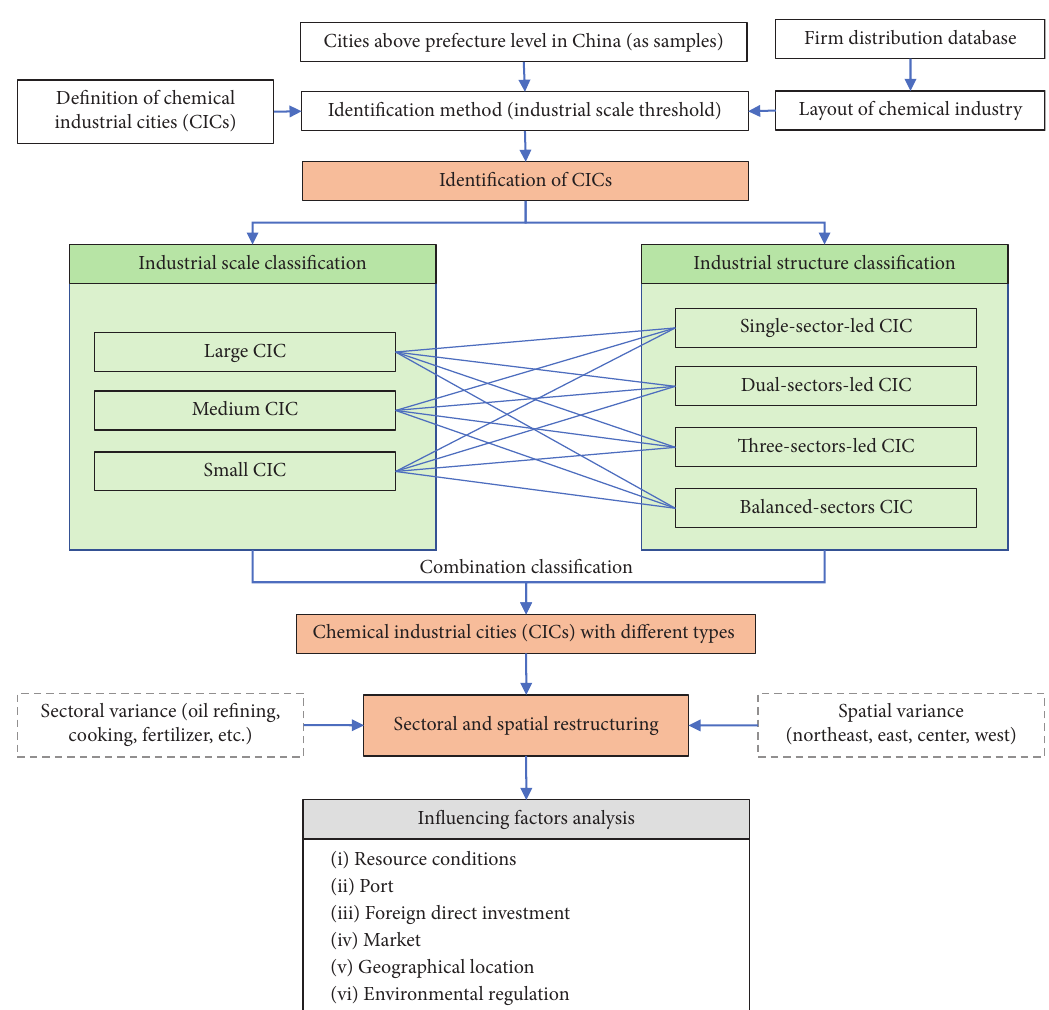
Figure 1: Research